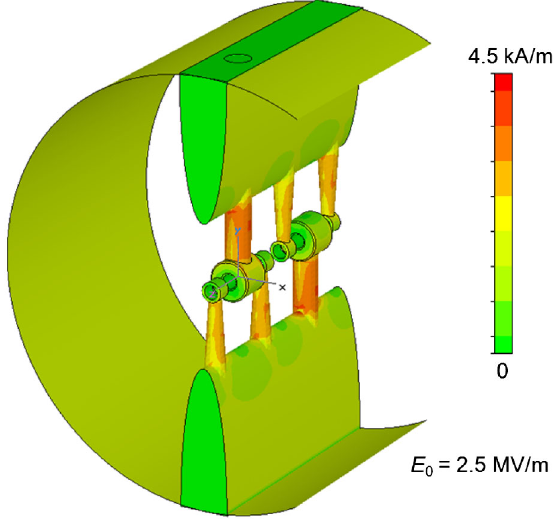
FIG. 3. Surface-current-magnitude distribution in the modified ¼ 0 : 04 (the cavity wall is partially cut for IH1-3 structure for (cid:1) g better